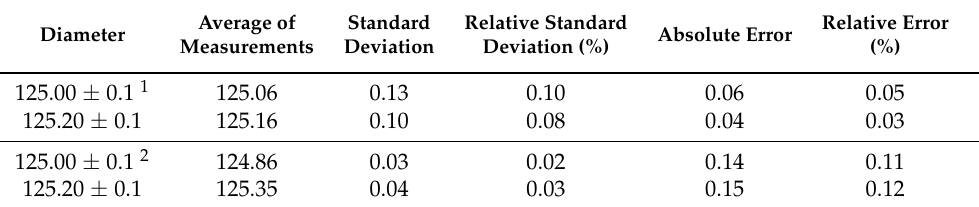
Table 2. Actual measurement results (unit: µ m).